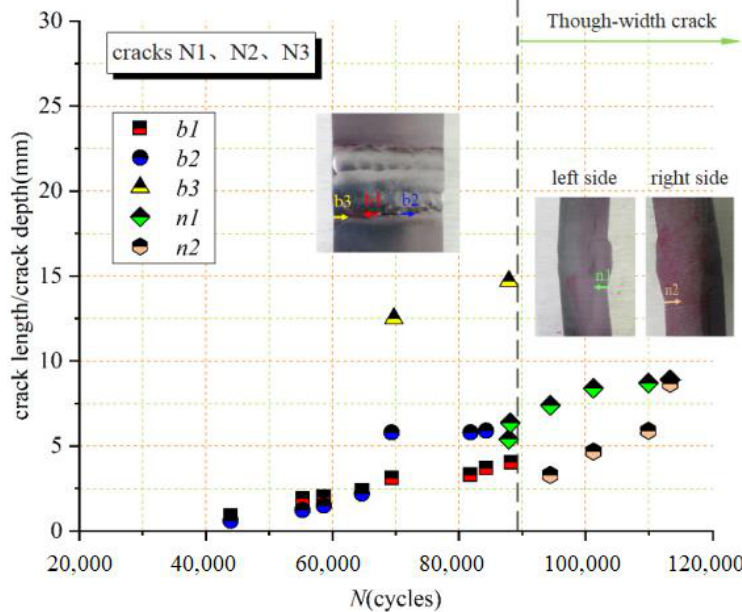
Figure 16. Crack growth versus cycles in positions N1, N2 and N3.